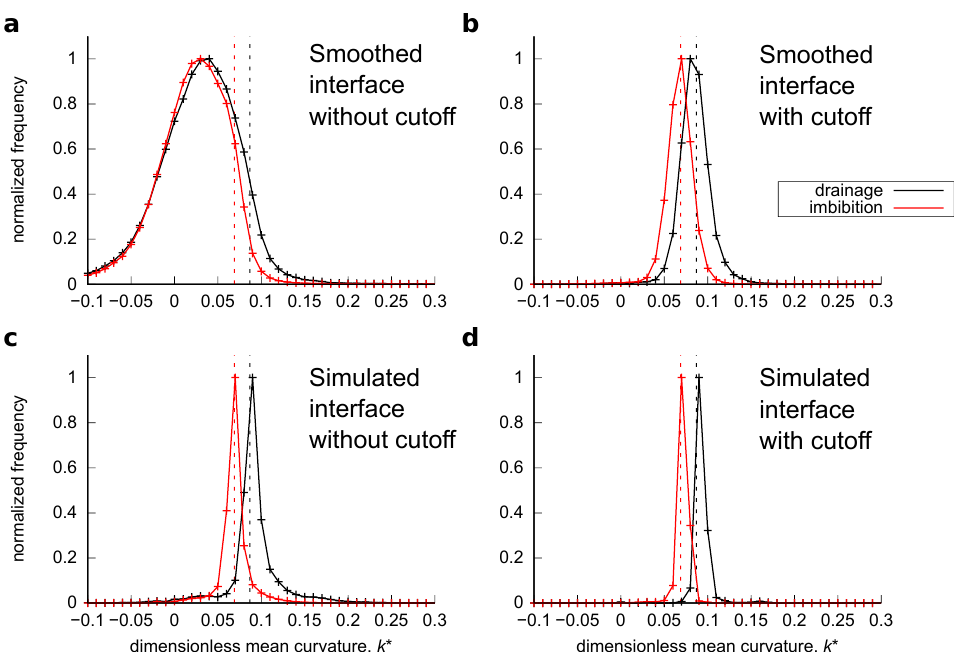
Figure 13. Histograms of the computed curvatures for the bead pack. ( a ) Interfacial curvature computed on the smoothed interface after drainage and imbibition without the distance cutoff and ( b ) with the distance cutoff. ( c ) Interfacial curvature computed on the simulated interface after the drainage and imbibition without the distance cutoff and ( d ) with the distance cutoff.